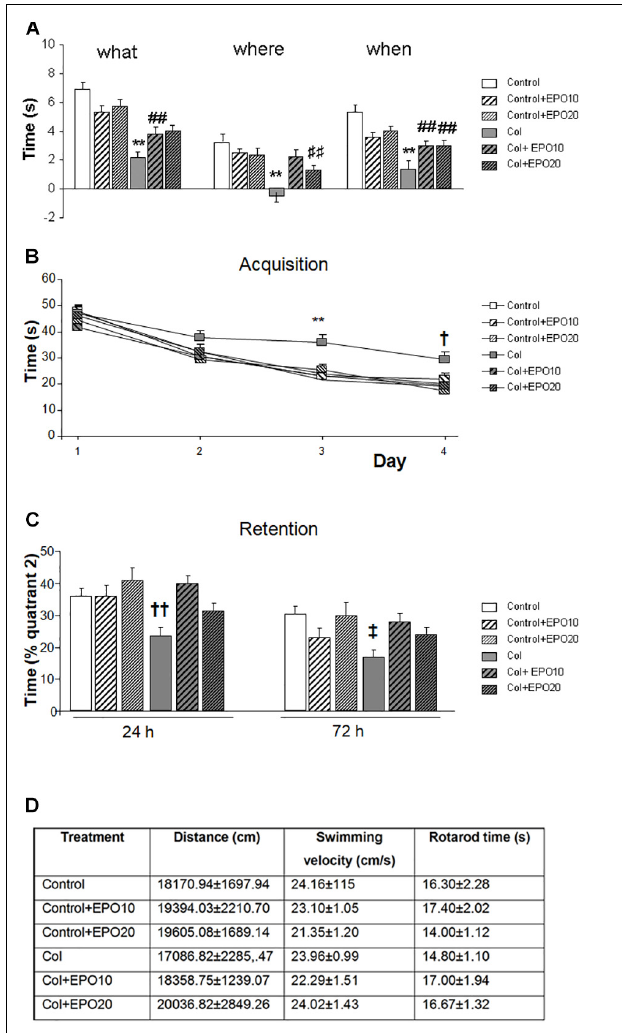
FIGURE 1 | EPO treatment significantly reduces GM-IVH cognitive impairment at P70. (A) Episodic memory is significantly impaired at P70 after inducing